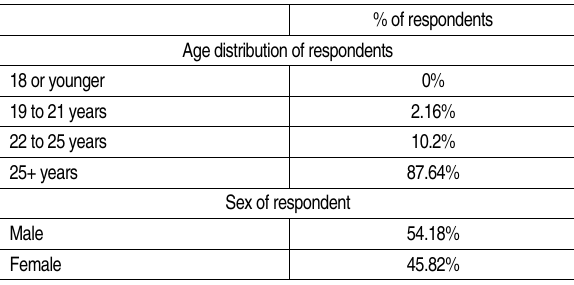
Table 1. Demographic profile of